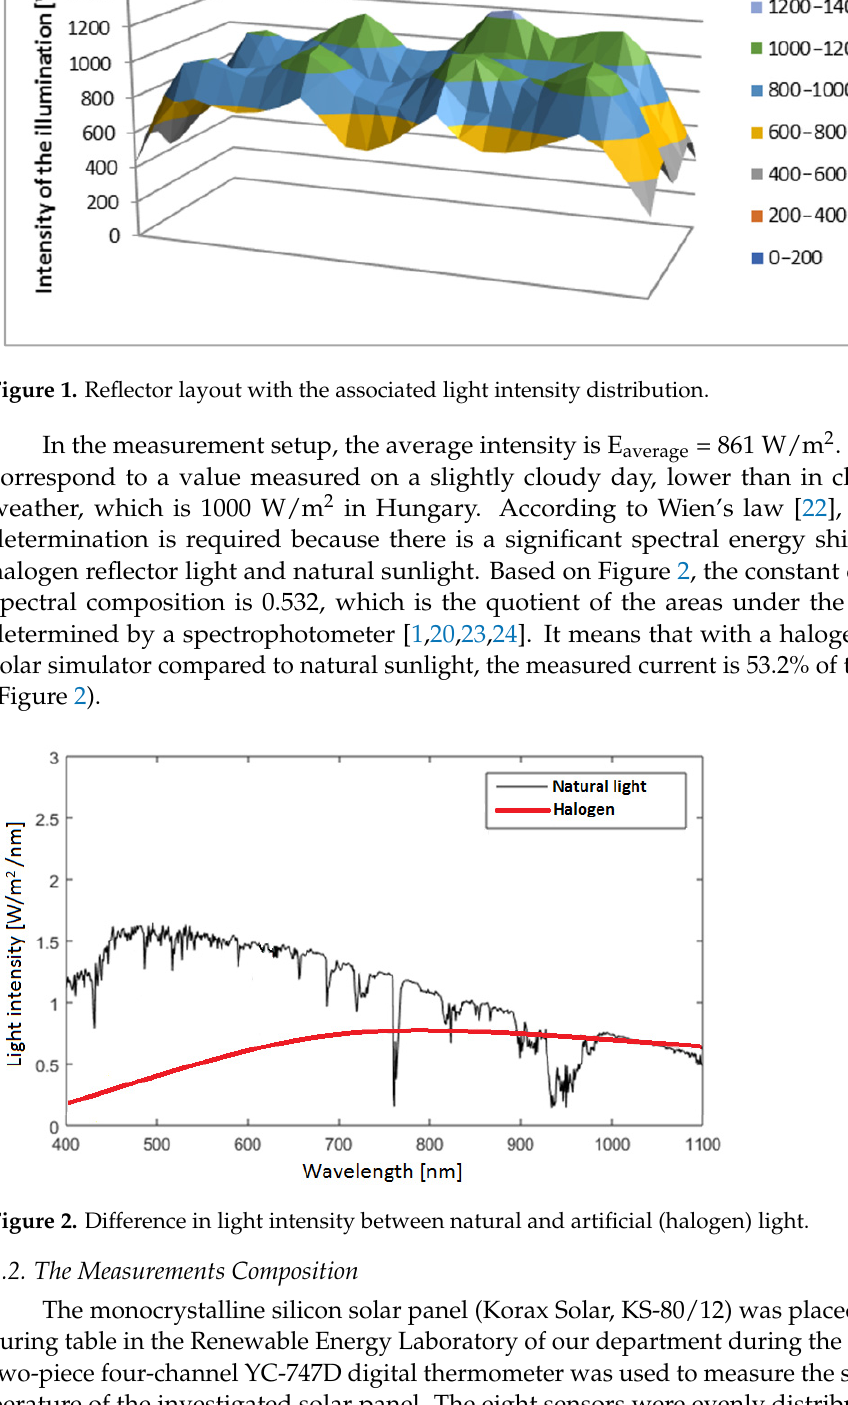
Figure 1. Reflector layout with the associated light intensity distribution.